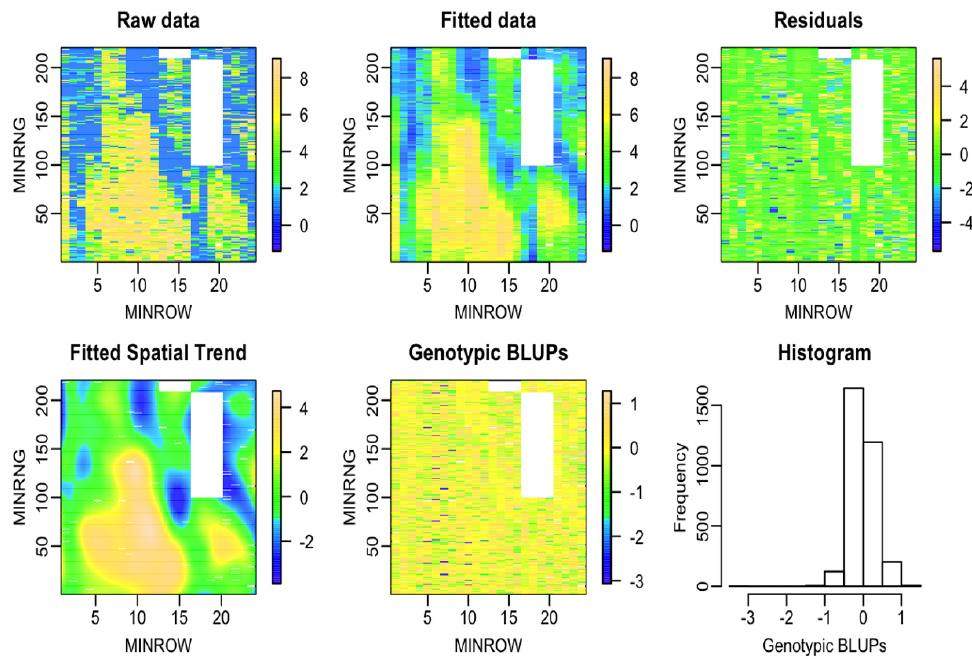
Figure 6. Heatmaps and histogram from data set 3. The rectangle layout is 24 rows (X-axis) by 220 ranges (Y-axis) with a total of 5280 plots. The white area on the right side of each heatmap is the plot without data. Sub-figures show values either from the raw field image, or as indicated in headings: fitted, or corrected with residuals or genomic BLUP values.